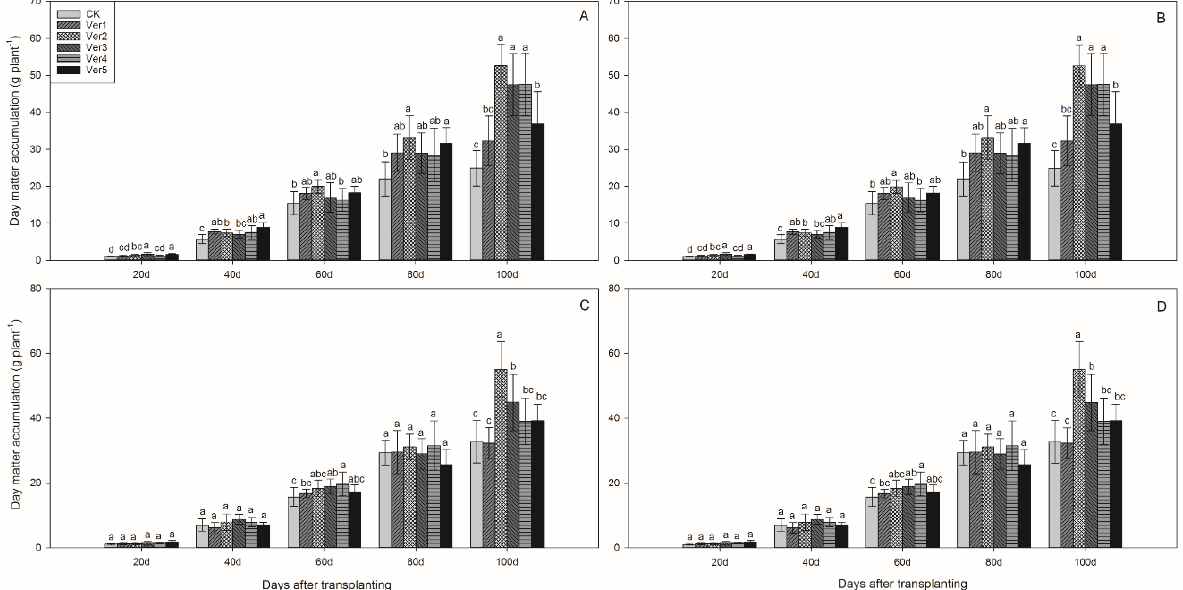
Figure 4. Effects of different vermicompost rates on dry matter weight of fragrant rice cultivars. ( A ) Meixiangzhan ‐ 2 in the early lug; ( B ) Meixiangzhan ‐ 2 in the late lug; ( C ) Xiangyaxiangzhan in the early lug; ( D ) Xiangyaxiangzhan in the late lug. Columns with same letters are not significantly different at p < 0.05.